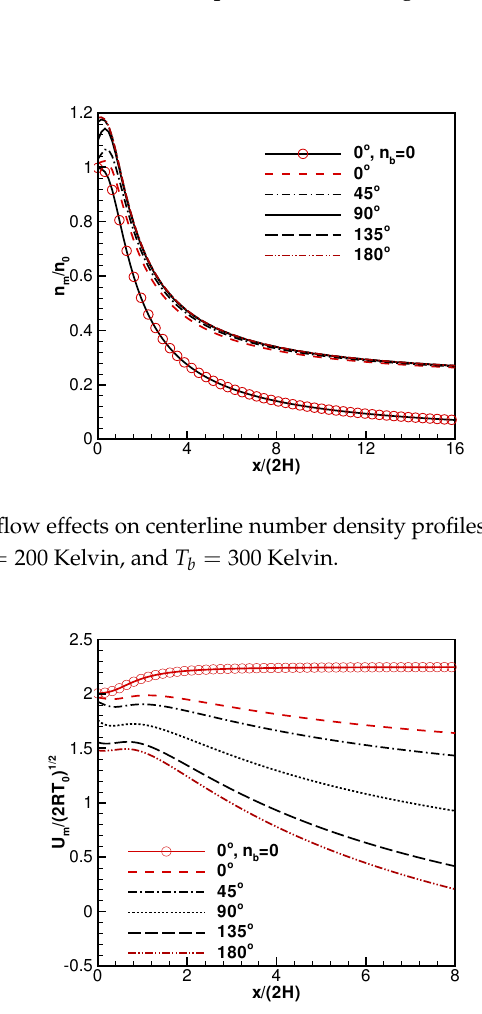
Figure 9. Background flow effects on centerline u-velocity component profiles for the mixture, n b / n 0 = 0.2, S 0 = 2.0, S b = 1.0, T 0 = 200 Kelvin, and T b = 300 Kelvin.